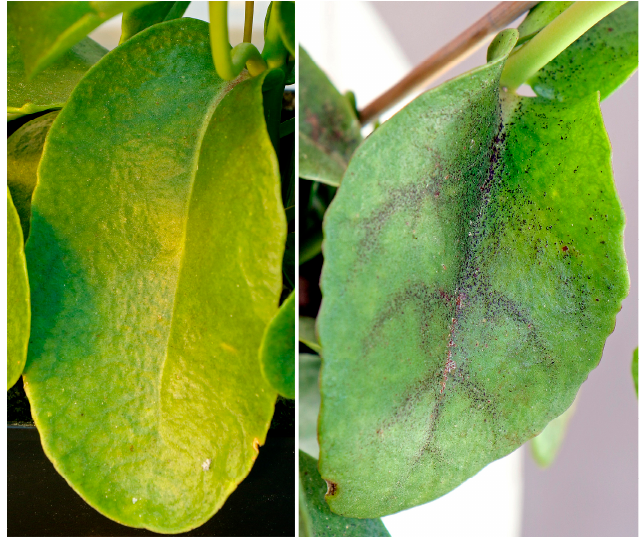
Figure 7. Typical visual toxicity symptoms on leaves of H. maximum plants treated with 2.0 g L –1 Mn ( right ) in comparison to control plants ( left ) two weeks after full treatment (Experiment 2).